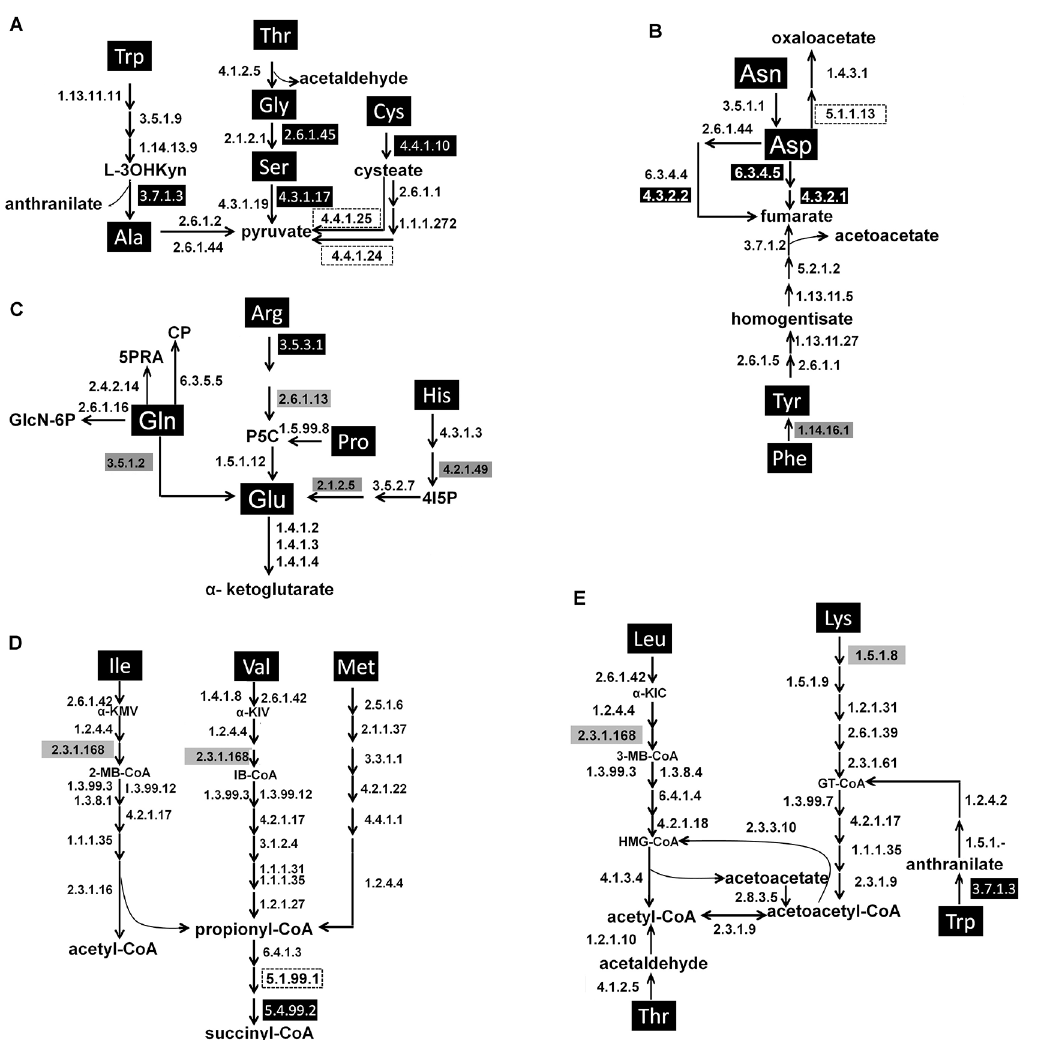
Fig 1. Proposed major degradation pathways of amino acids in Nilaparvata lugens . A) Pyruvate pathway; B) Oxaloacetate and fumarate pathway; C) α -Ketoglutarate pathway; D) Succinyl-CoAand acetyl-CoA pathway; and E) Acetoacetate pathway. The black arrows indicate reactions supported by genome and/or transcriptome annotation data. The numbers represent EC numbers. See Table 1 for details of the enzymes. Enzymes encoded by YLS genome are marked with white numbers in black boxes; the enzymes encoded by Ni . lugens genome are denoted with black number in grey boxes; the enzymes are homologous to those from both Ni . lugens and YLS genomes are given with black numbers without boxes; and the enzymes not found in Ni . lugens and YLS genome and transcriptome data are marked with black numbers in dashed